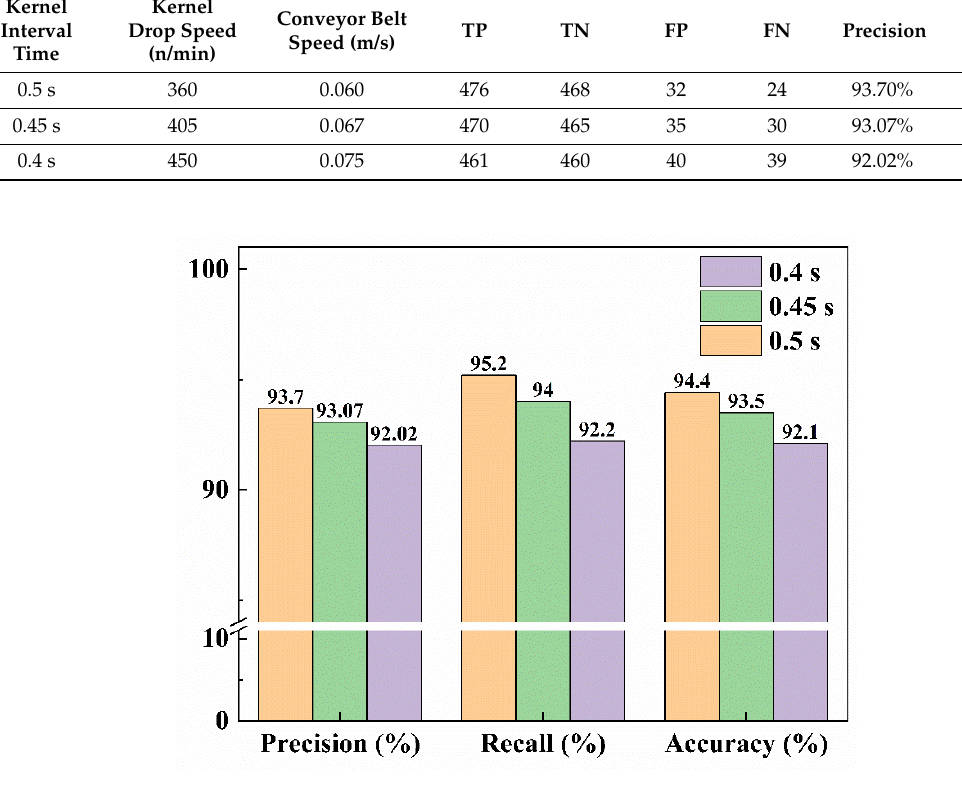
Figure 14. Relationship between speed and accuracy.